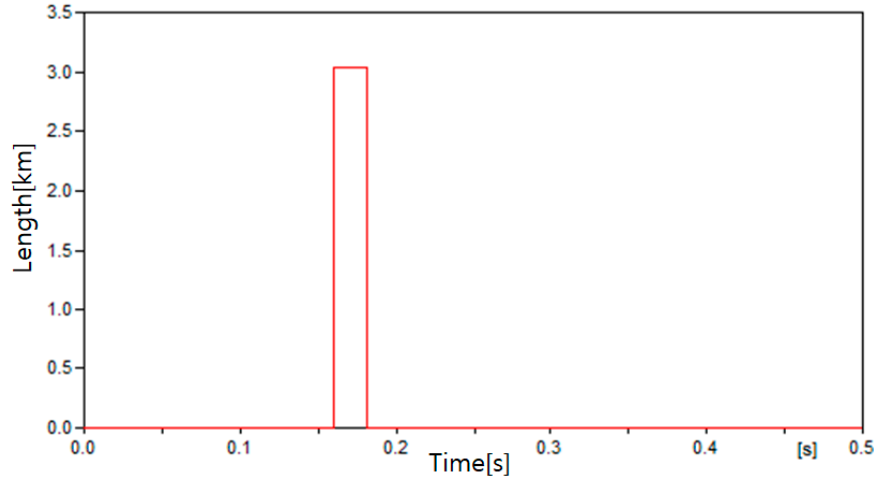
Figure 25. Fault location in Case 7.